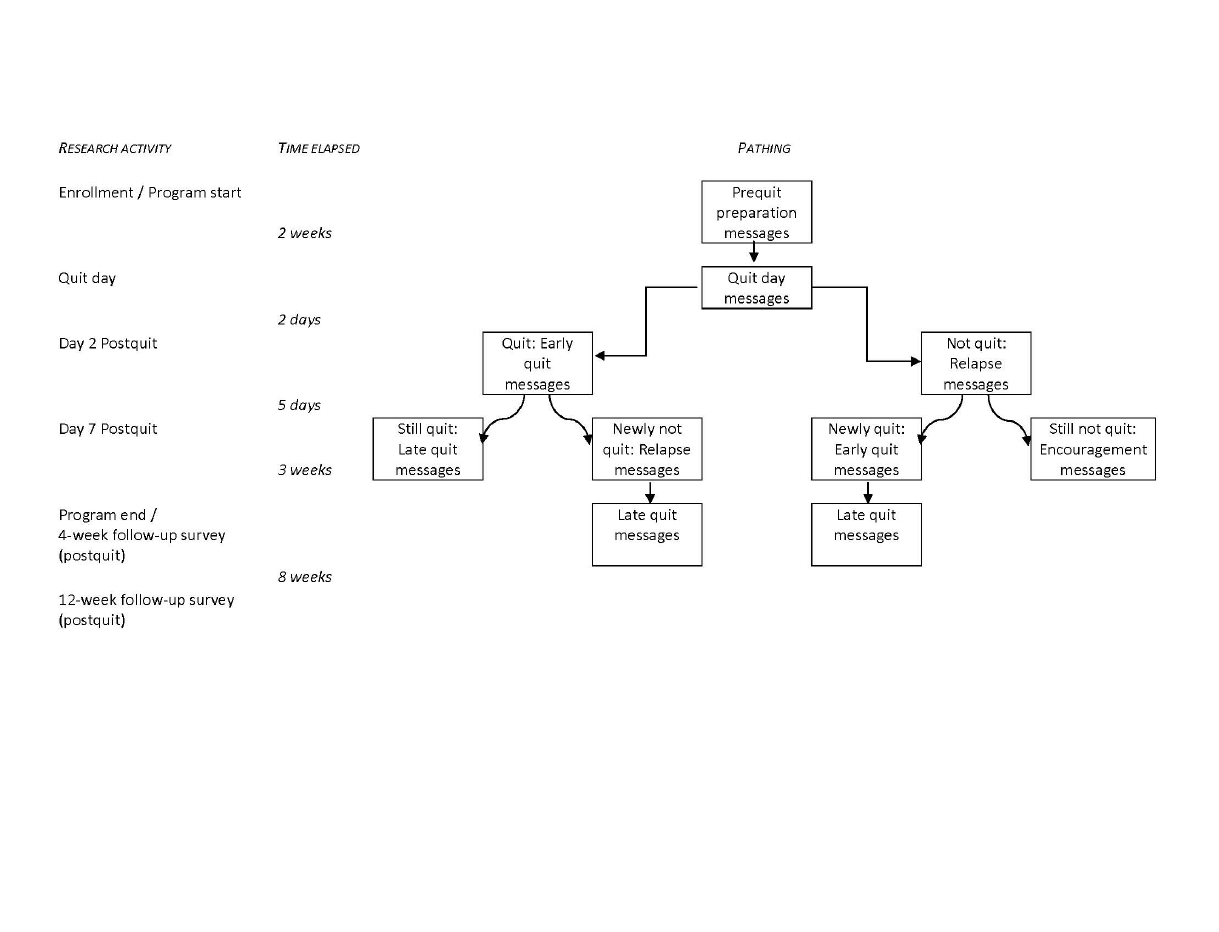
Figure 1. SMS Turkey text messaging program